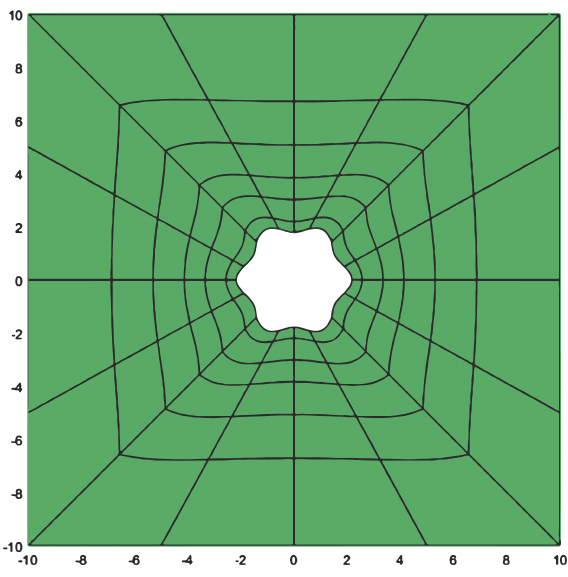
Figure 14. Case 2: physical domain and mesh with h 2 -refinement.